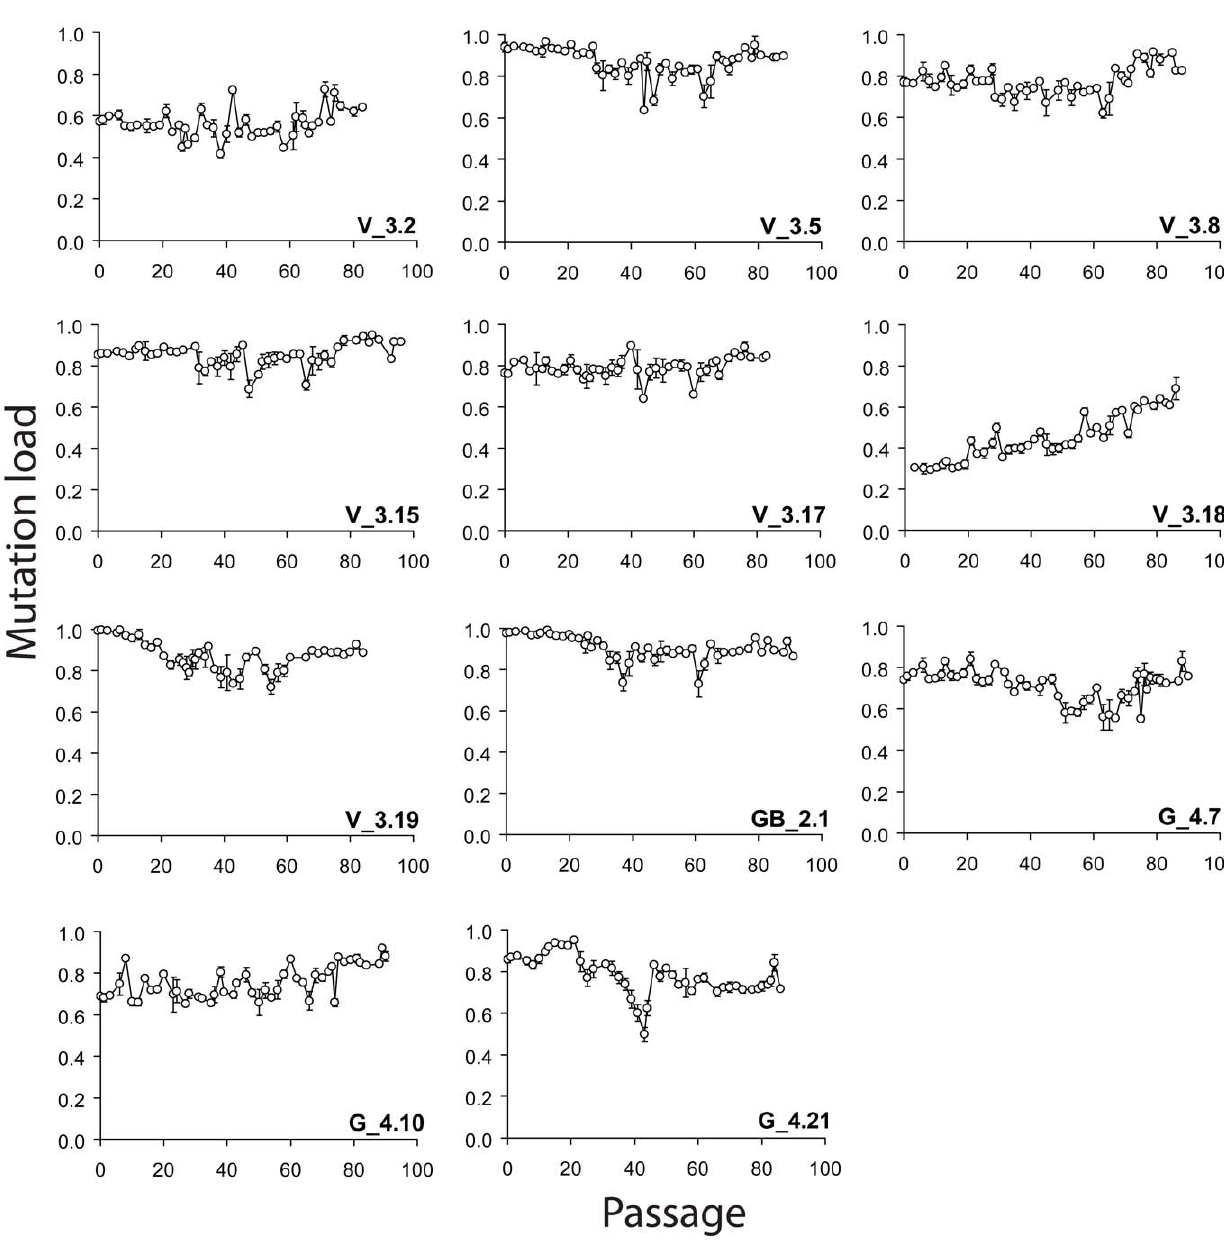
Figure 3. Evolution of bulk mtDNA mutation load during long term continuous culture of 11 cybrid clones. Average m.3243A . G mutation loads were determined with PCR/RFMT on bulk DNA in triplicate. The size of the data marker masks error bars of most data points.